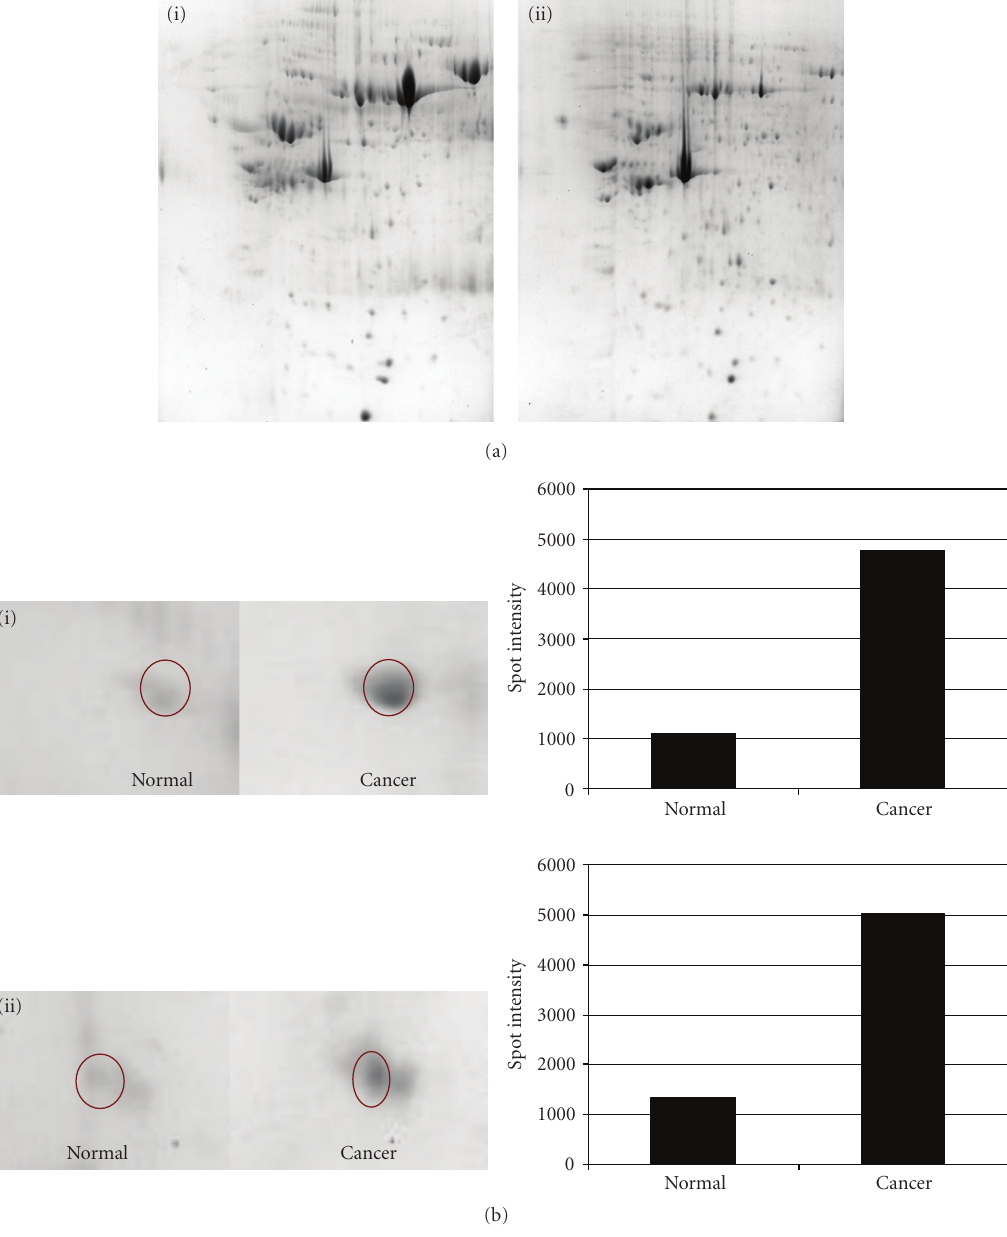
Figure 1: (a) 2D gel image of TRIS extract from (i) normal and (ii) cancer breast tissues of same patient. (b) Protein spot intensity of (i) calreticulin and (ii) 14-3-3 protein zeta from normal and cancerous tissue of same